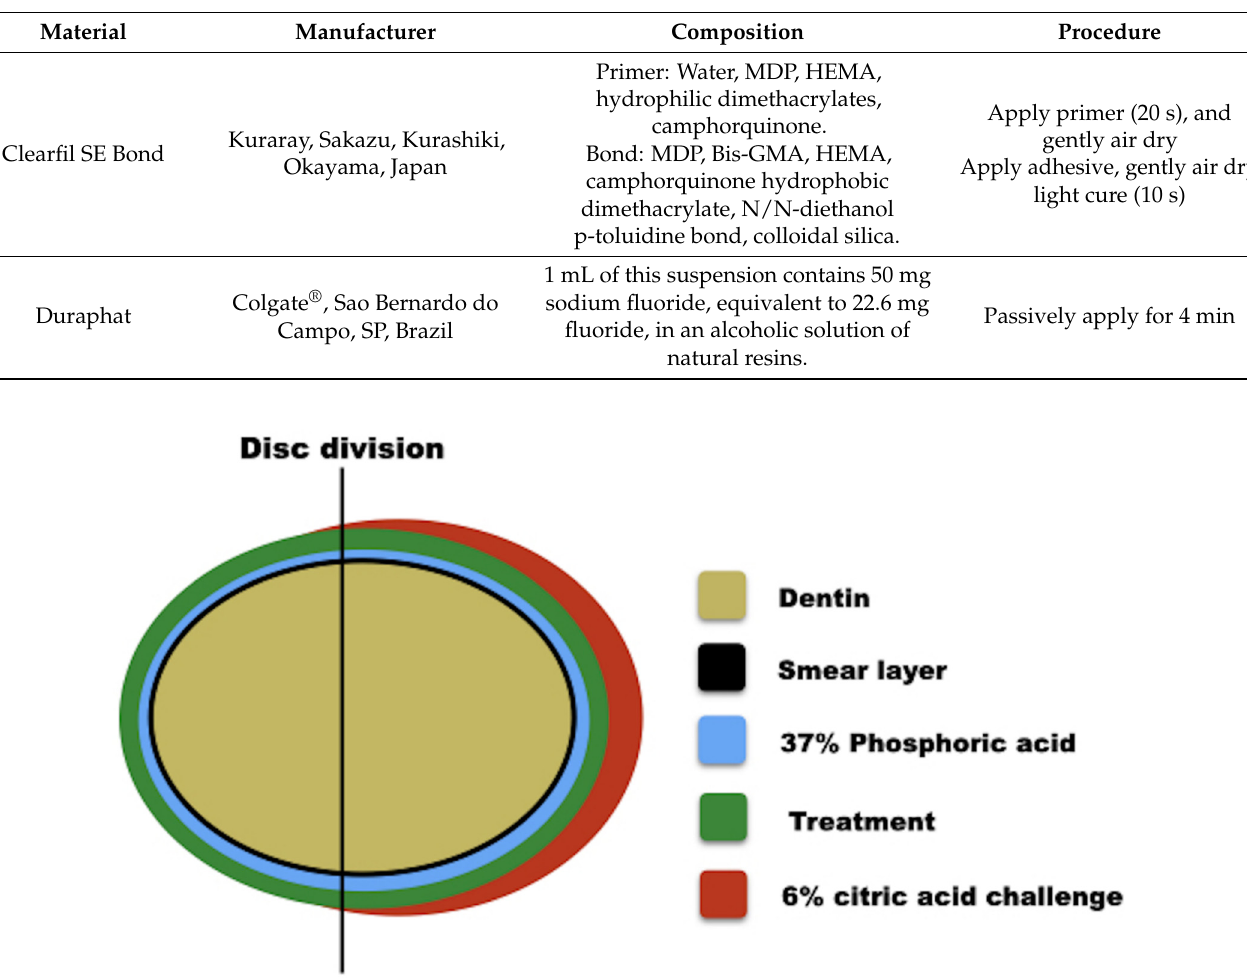
Table 1. Description of brand name, manufacturer, composition, and procedure of all materials used in this study.